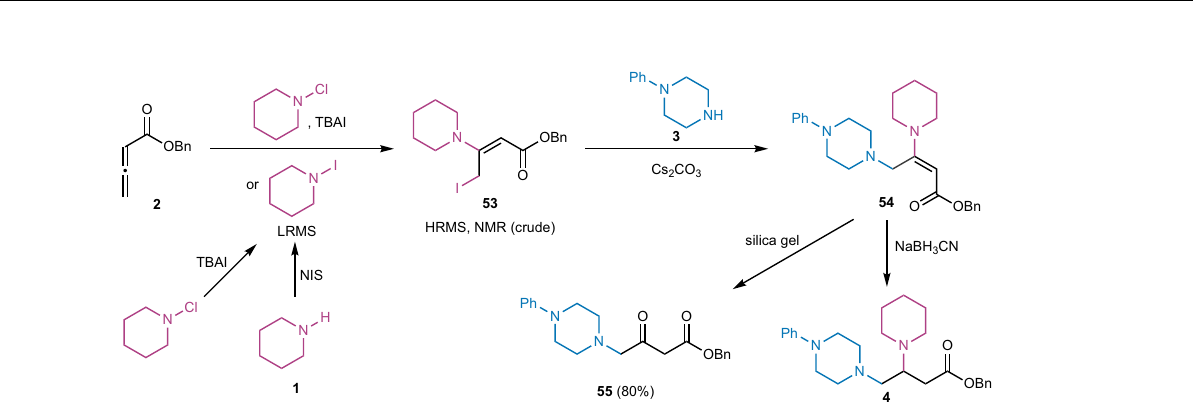
Fig. 4 | Identi fi cation of key intermediates. TBAI tetra- n -butylammonium iodide. NIS N